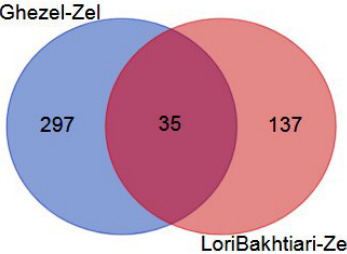
Figure 8. Venn diagram of the differentially expressed genes in the current study (Ghezel vs. Zel comparison) and Bakhtiarizadeh et al. (2019) study (Lori-Bakhtiari vs. Zel